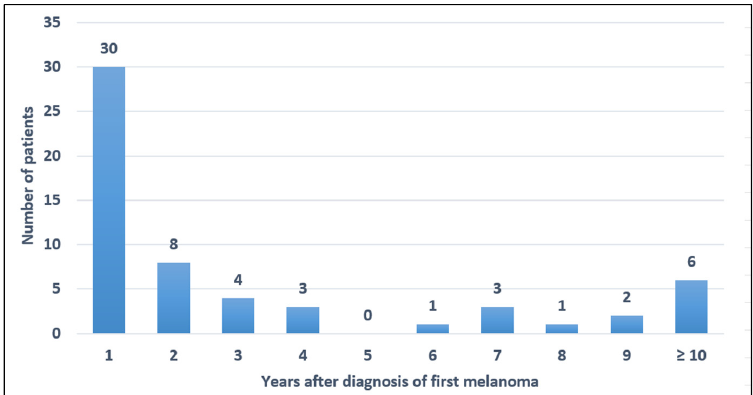
Figure 1. Time of diagnosis of the second melanoma from the first melanoma.